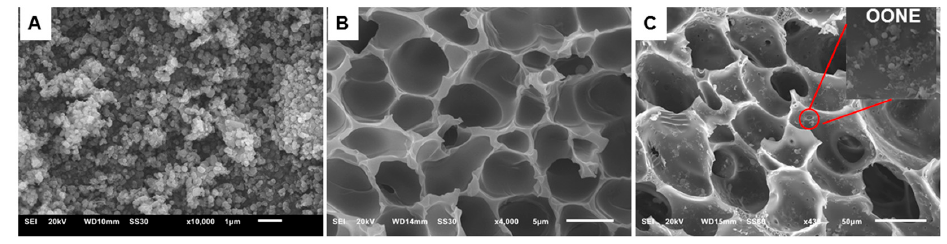
Figure 4. SEM micrographs of ( A ) OONE, ( B ) TMCTH, and ( C )